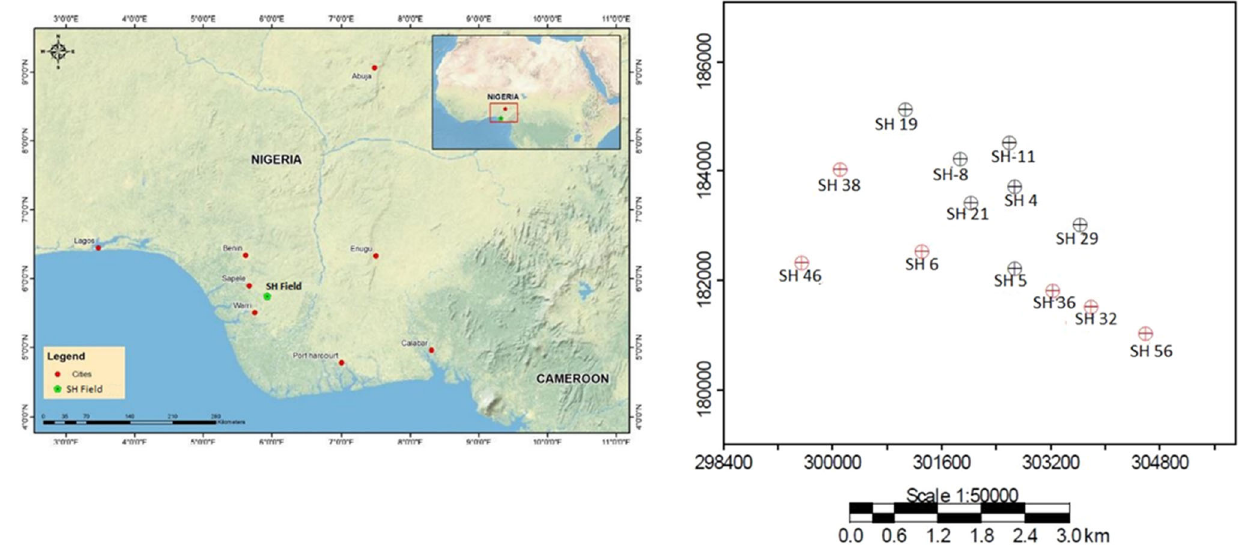
Fig. 1 Base map of the study area showing well locations in the SH field (modified after Edigbue et al. 2015)